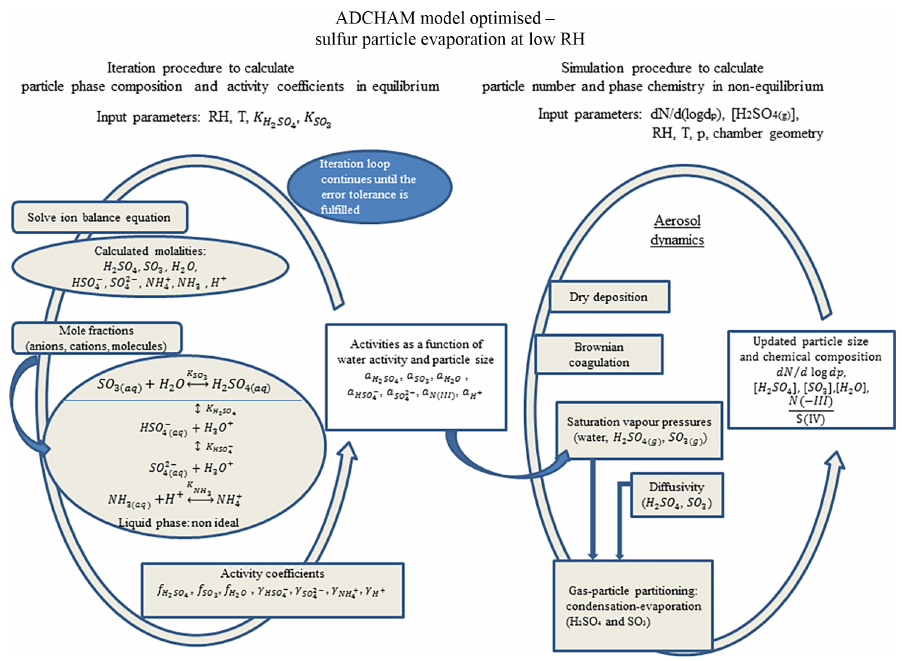
Figure 1. Schematic of the ADCHAM model optimised for the sulfur particle evaporation at low RH.